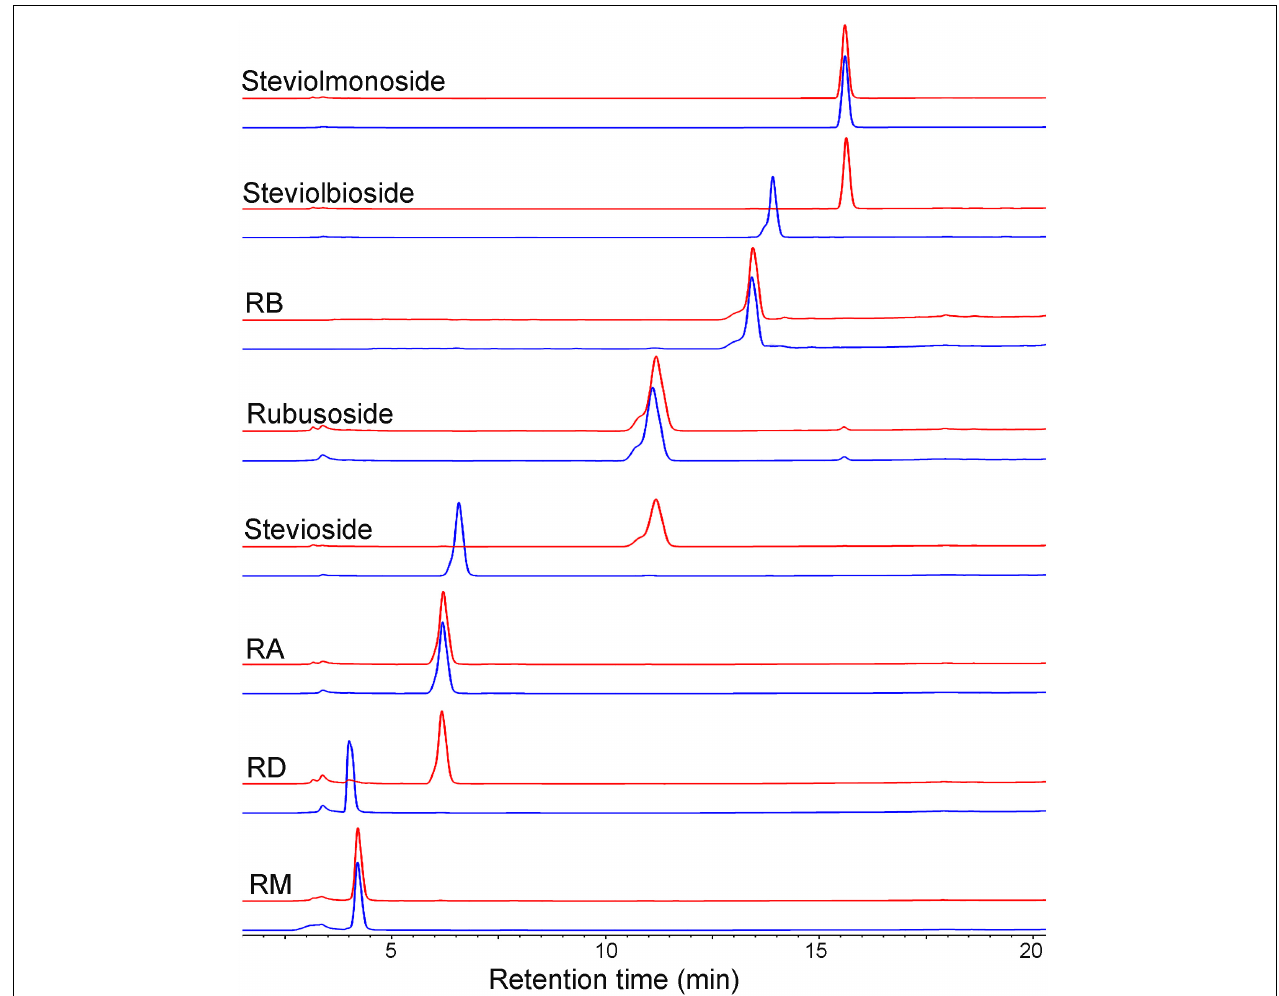
FIGURE 4 | HPLC analysis of the hydrolysis products of steviol glucosides by Cs BGL. Reactions were performed by incubating Cs BGL (0.5 U/ml) with 5 mM RM, RD, RA, stevioside, rubusoside, RB, steviolbioside, and steviolmonoside in the 50 mM sodium phosphate buffer (pH 7.4) at 45 ◦ C for 5 min. The red lines represent the hydrolysis product of steviol glycosides by Cs BGL and the blue lines represent the control of steviol